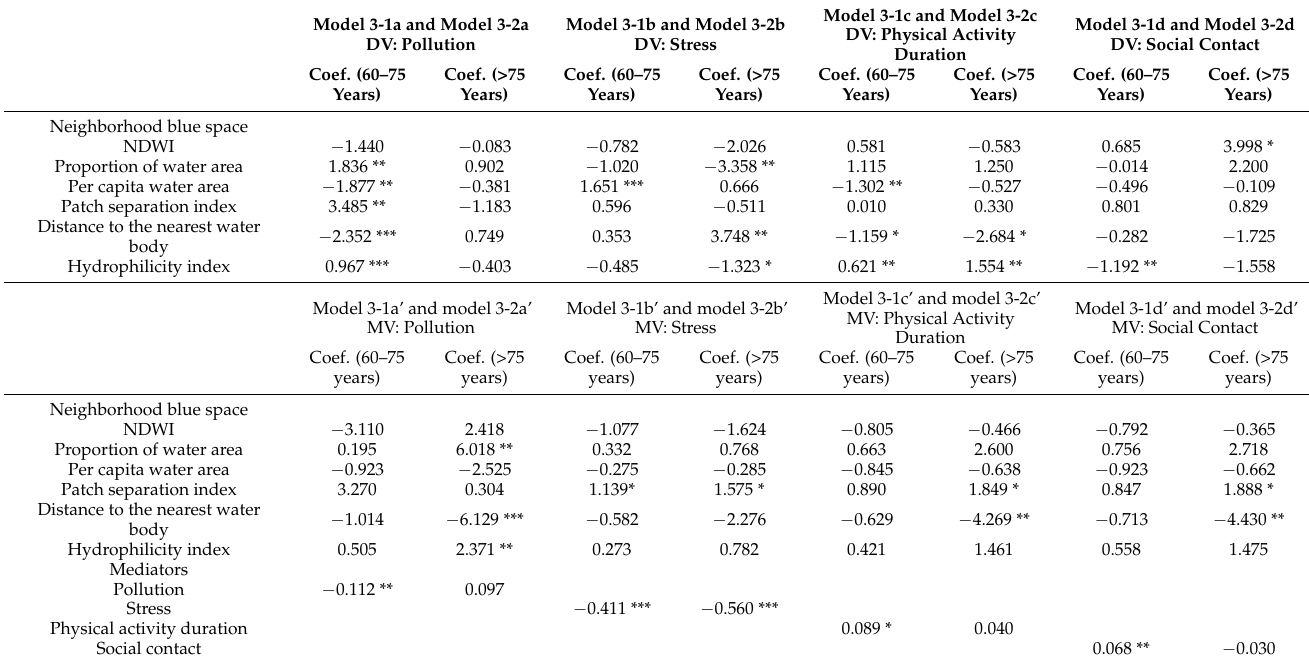
Table 6. Associations between neighborhood blue space, mediators, and SRH in age groups.